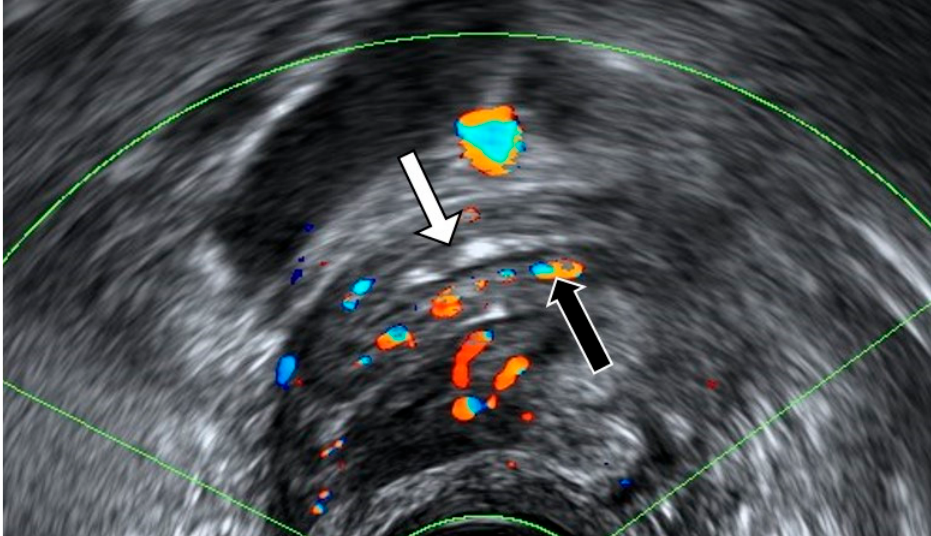
Figure 3. Longitudinal transvaginal ultrasound with color Doppler demonstrates the presence of intraluminal gas in the appendix (white arrow) and hyperemia (black arrow).